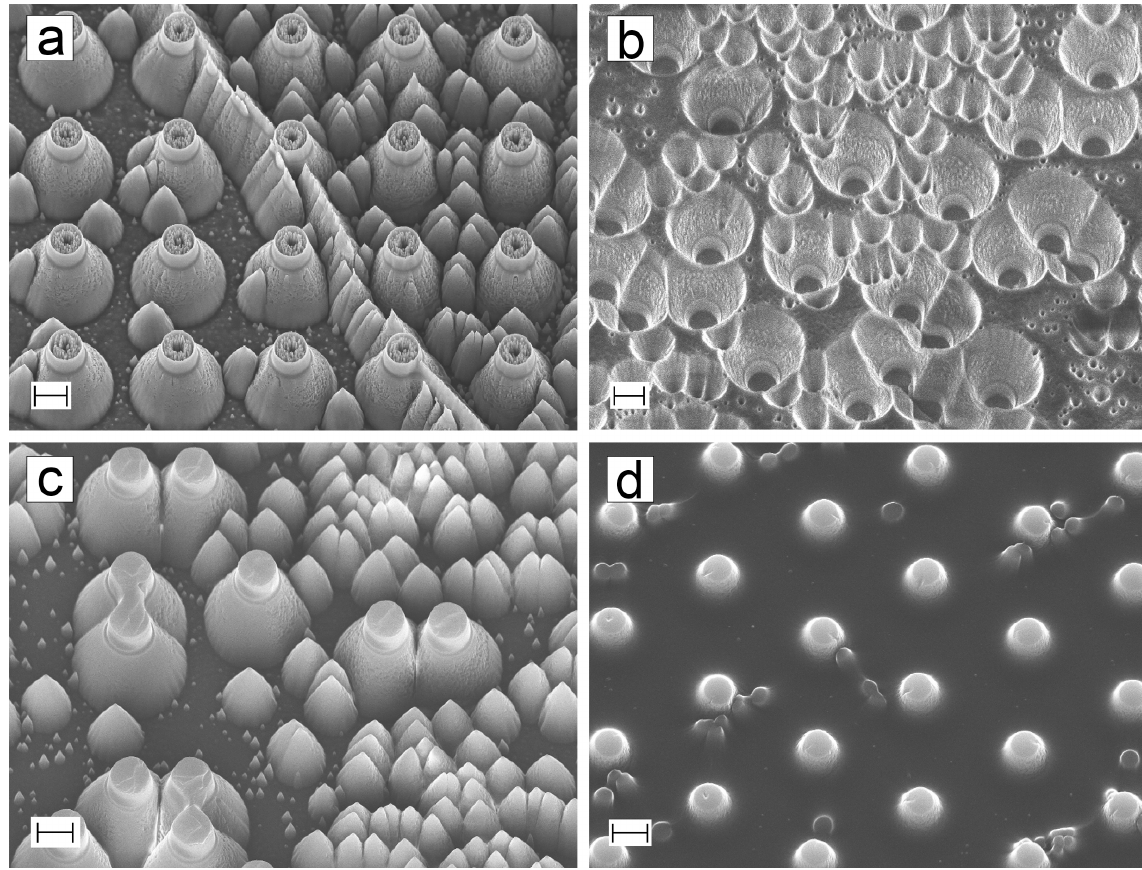
Figure 7. Carbon micro- and nanopillar fabrication by embossing and pyrolysis. ( a ) Dual-scale pillar-bSi structures had two kinds of topography: either the interpillar space had only a few nanopillars (left), or it was full of them (right). ( b ) The hPDMS-PDMS stamp. ( c ) The copy process into SU-8 layer was also successful with even the smallest of features. ( d ) Dual-scale pillar-bSi structures after pyrolysis. All scalebars: 2 µ